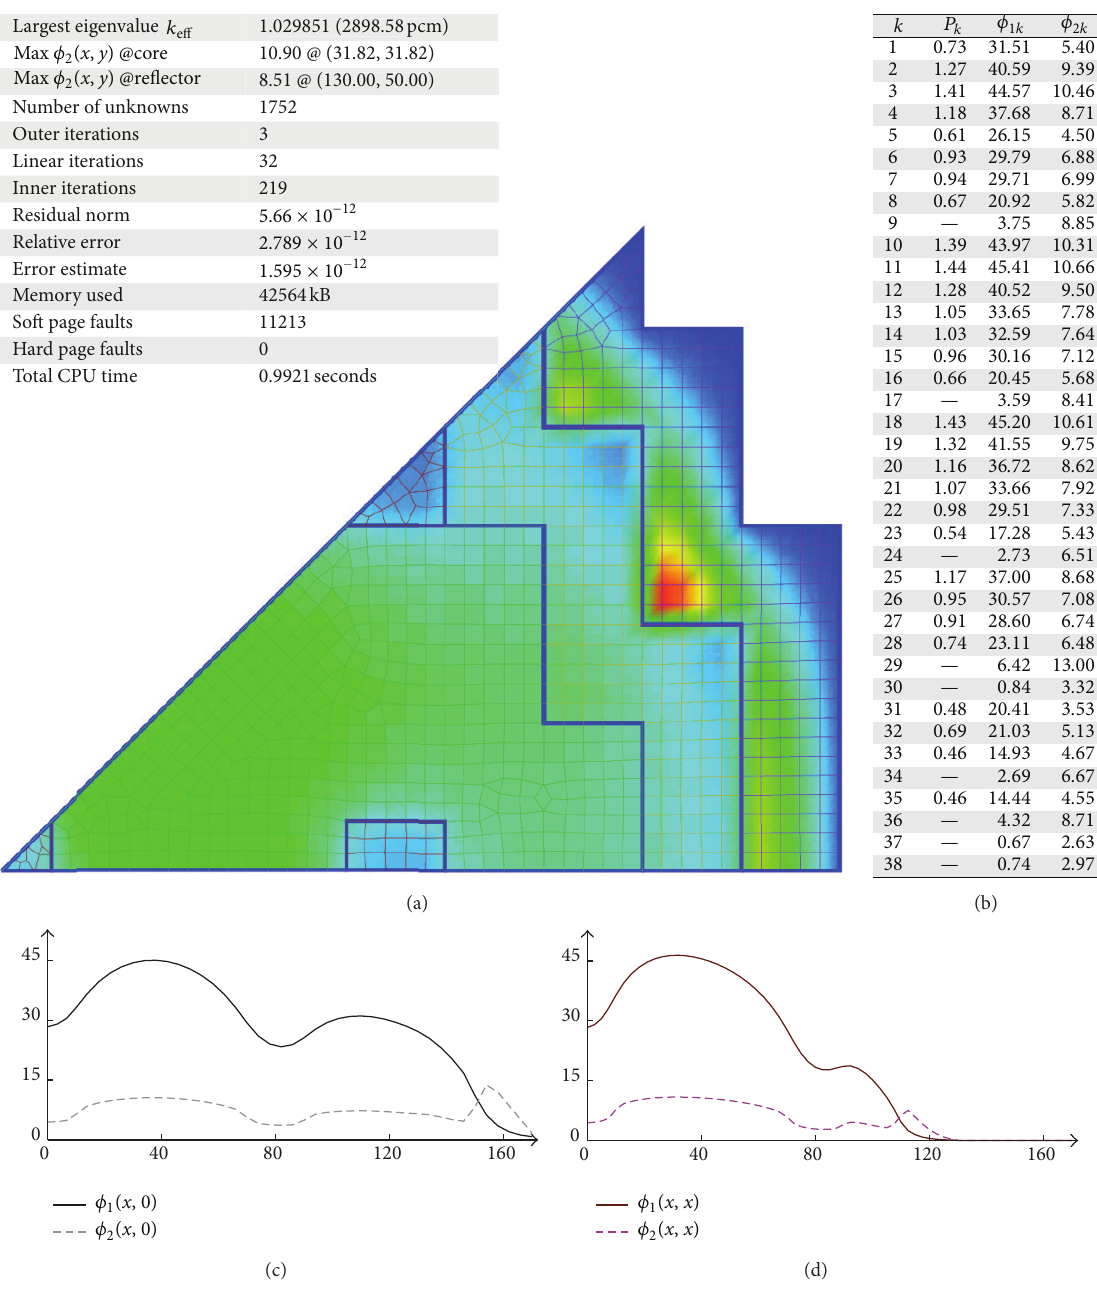
Figure 18: (a) Mesh and thermal flux distribution. (b) Power and fluxes. (c) Flux distribution 𝜙 𝑔 (𝑥,0) along the 𝑥 -axis. (d) Flux distribution (𝑥,𝑥) along the 𝜙 𝑔